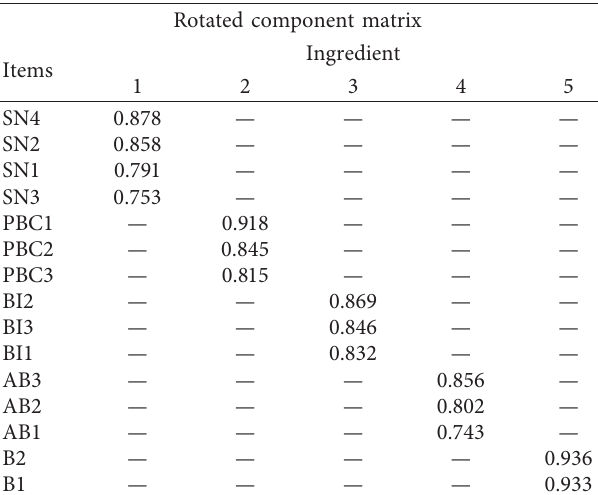
Table 9: Factor loading matrix after